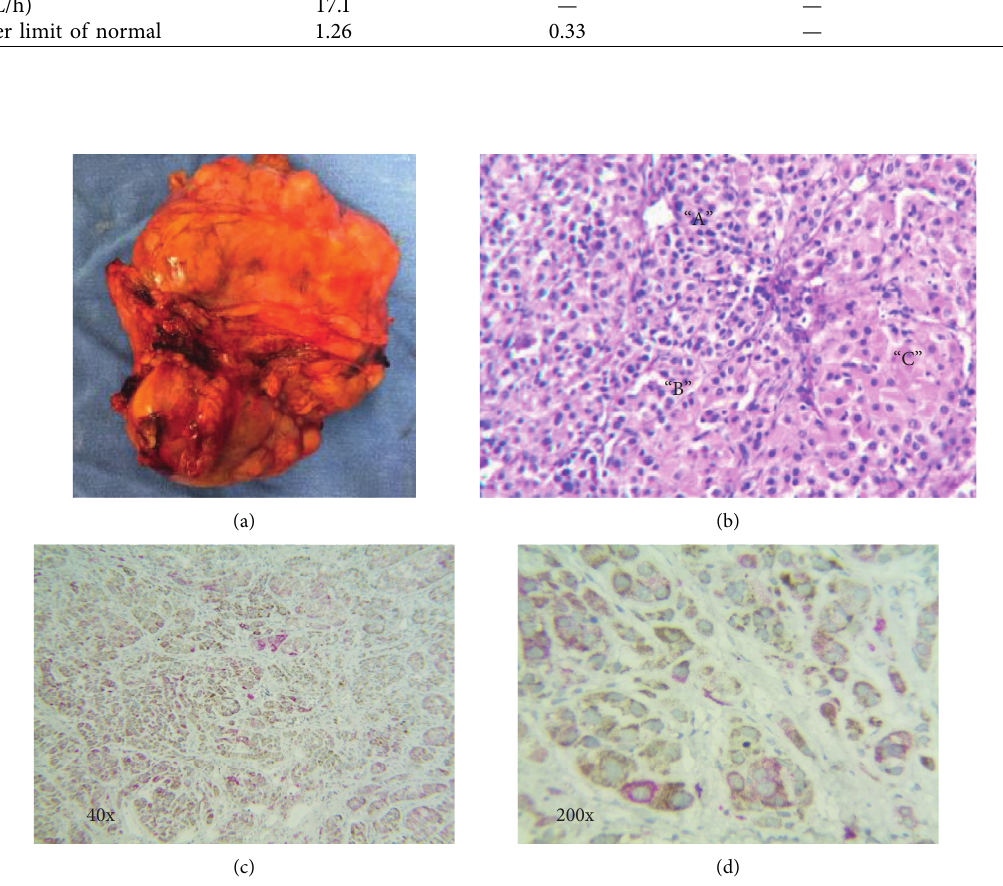
Figure 2: (a) Macroscopic view of the excised tumor. (b) Hematoxylin and eosin stain of the tumor (10x) showing three cellular patterns: “A” corresponds to the medullary neuroendocrine component, “C” corresponds to the cortical component, and “B” shows cells of an intermediate phenotype. (c, d) Double-label immunohistochemistry, with antibodies to CgA linked to horseradish peroxidase (brown) and antibodies against inhibin linked to alkaline phosphatase